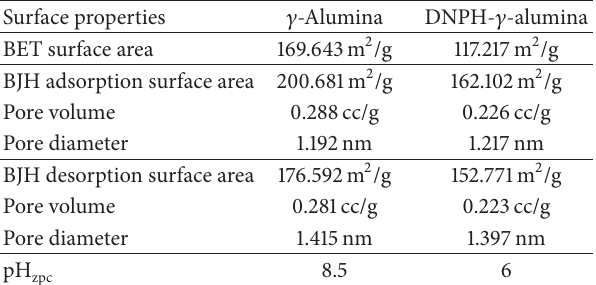
Figure 3: FTIR spectrum of DNPH- 𝛾 -alumina. Table 1: Surface characteristics of 𝛾 -alumina and DNPH- 𝛾 -